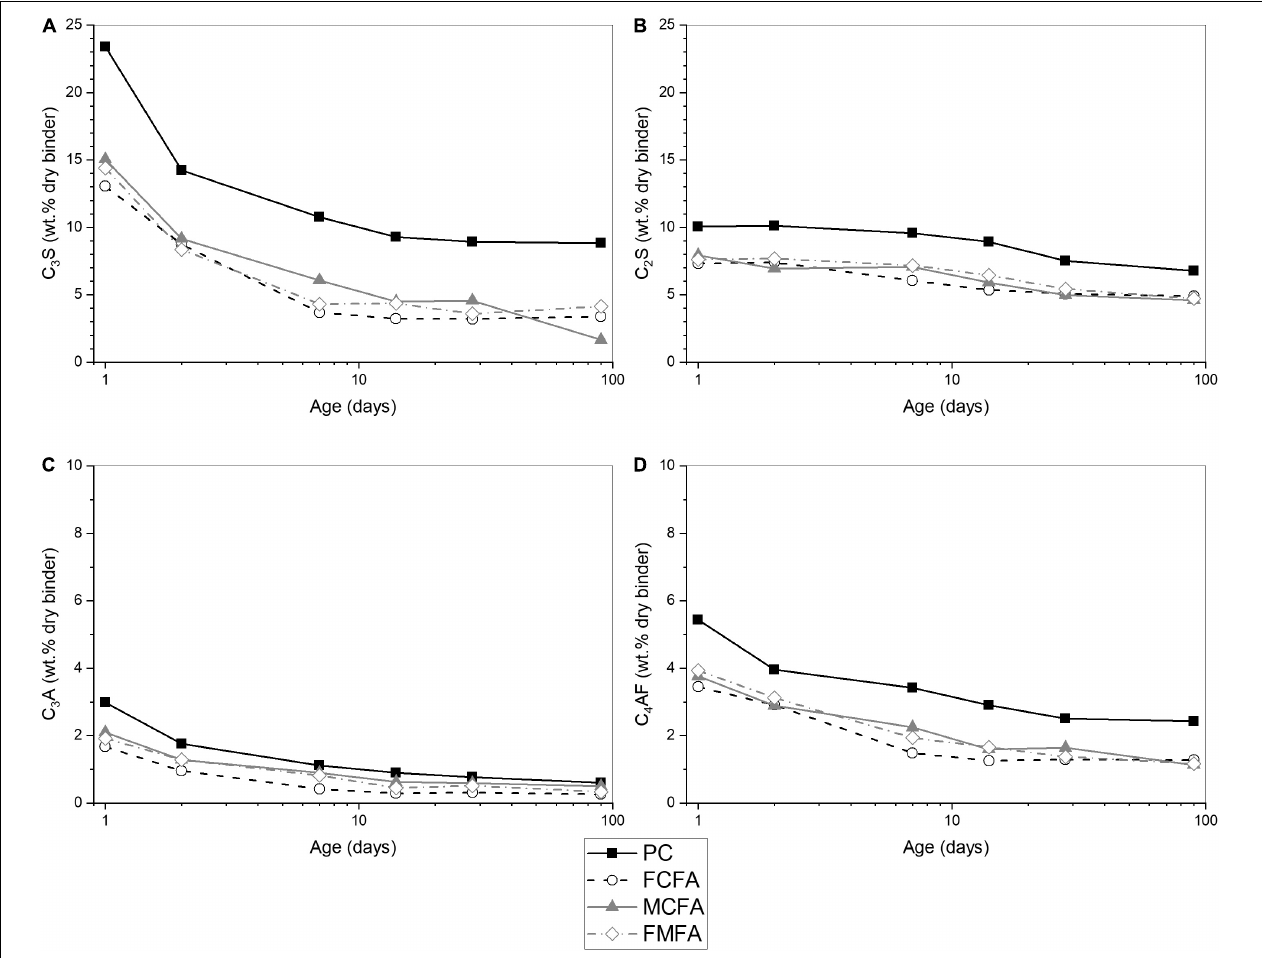
FIGURE 6 | XRD-Rietveld analysis results showing the consumption of the main clinker phases from 1 to 90 days of hydration for the fly ash blended cements and the reference Portland cement. (A) : C 3 S, (B) : β -C 2 S, (C) : C 3 A, (D) : C 4 AF.